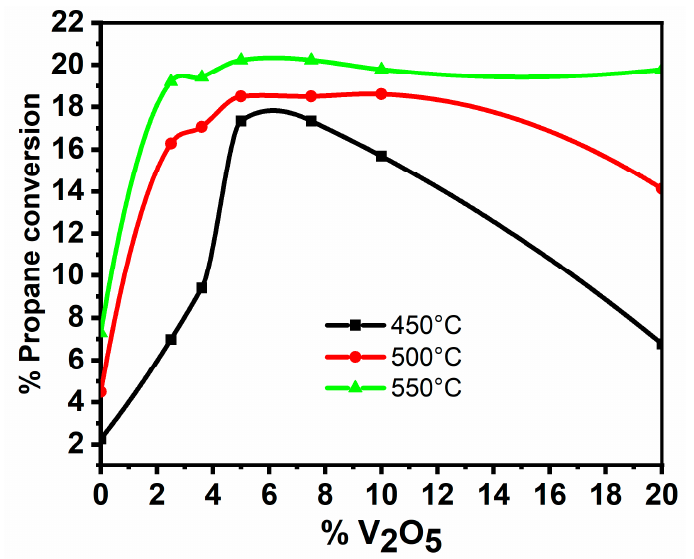
Figure 11. Evolution of the propane conversion as a function of the V 2 O 5 content and temperature for a reaction mixture air and propane.